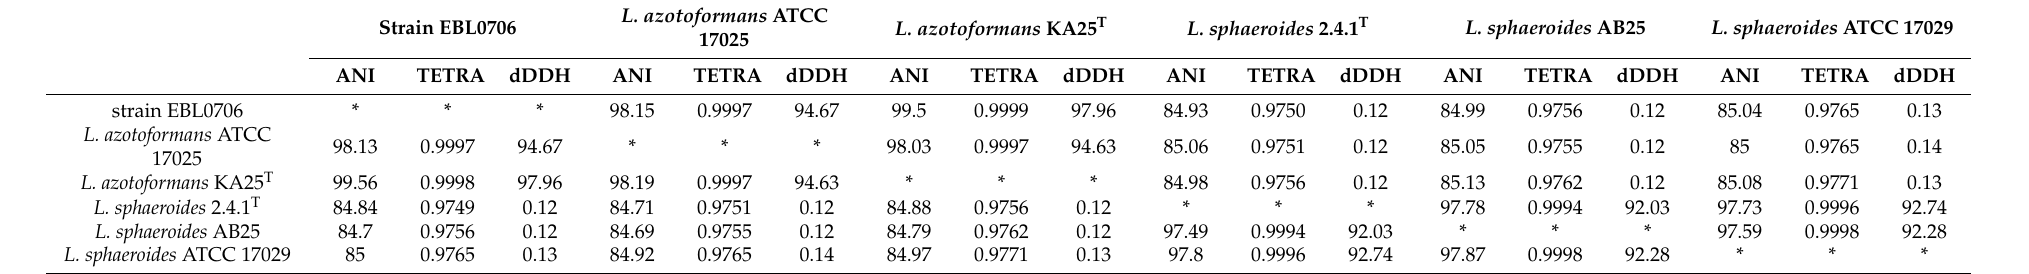
Table 2. Average nucleotide identity (ANI), tetra nucleotide signatures (TETRA) and digital DNA–DNA hybridization (dDDH) analyses between strain EBL0706 and Luteovulum strains. The asterisk represented the result of